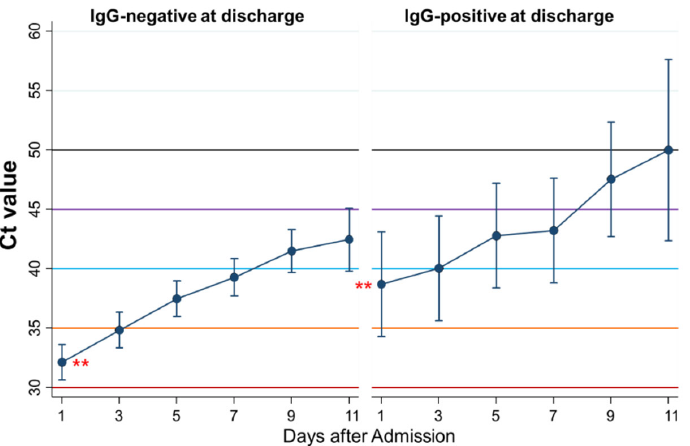
Figure 10. Differential kinetics of Ct values between patients with negative and positive IgG at discharge. Mean Ct with 95% confidence intervals. When the Ct value is 40 or more, then the PCR test result is considered negative. ** represents a significant difference ( p < 0.005).